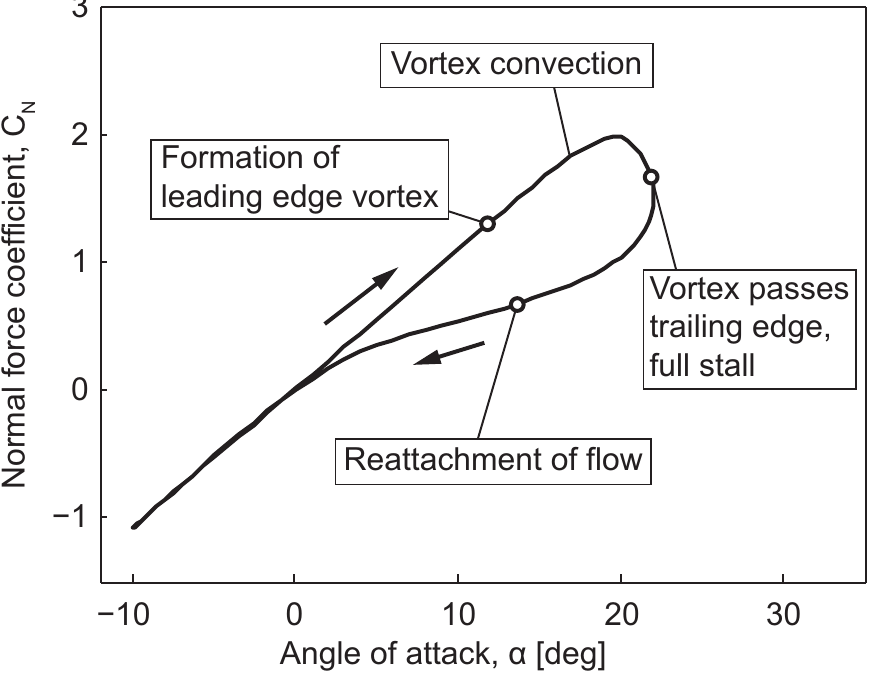
Figure 1. Illustration of dynamic stall; NACA0015, α = 6 + 16 sin ( ωt ) , k = 0 . 1 , M = 0 . 1 , c = 0 . 5 m , where k , M and c are the reduced frequency, Mach number and the chord length